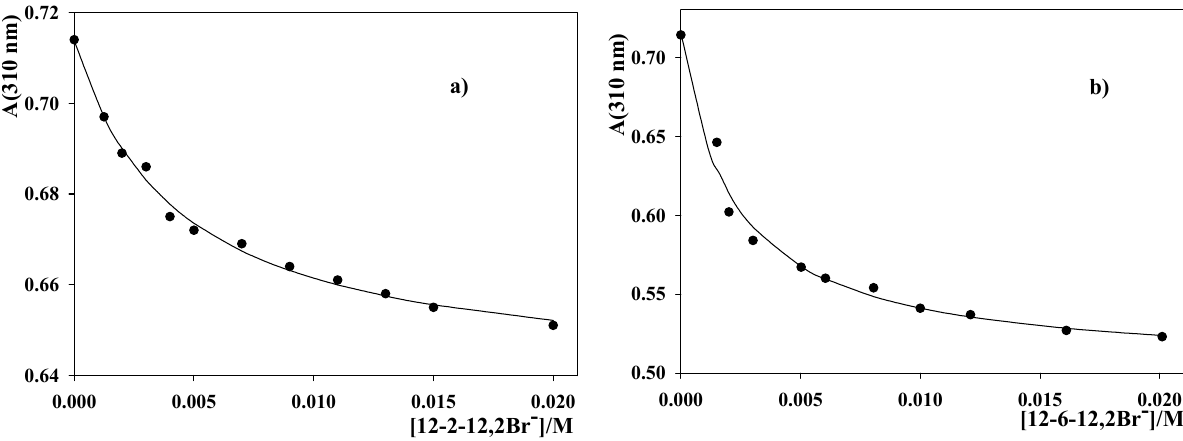
Figure 3. Dependence of the absorbance of 2-( p -nitrophenyl)ethyl bromide micellar solutions on surfactant concentration in: ( a )12-2-12,2Br − and ( b )12-6-12,2Br − . The fittings were done by using Equation (4). T = 303 K.